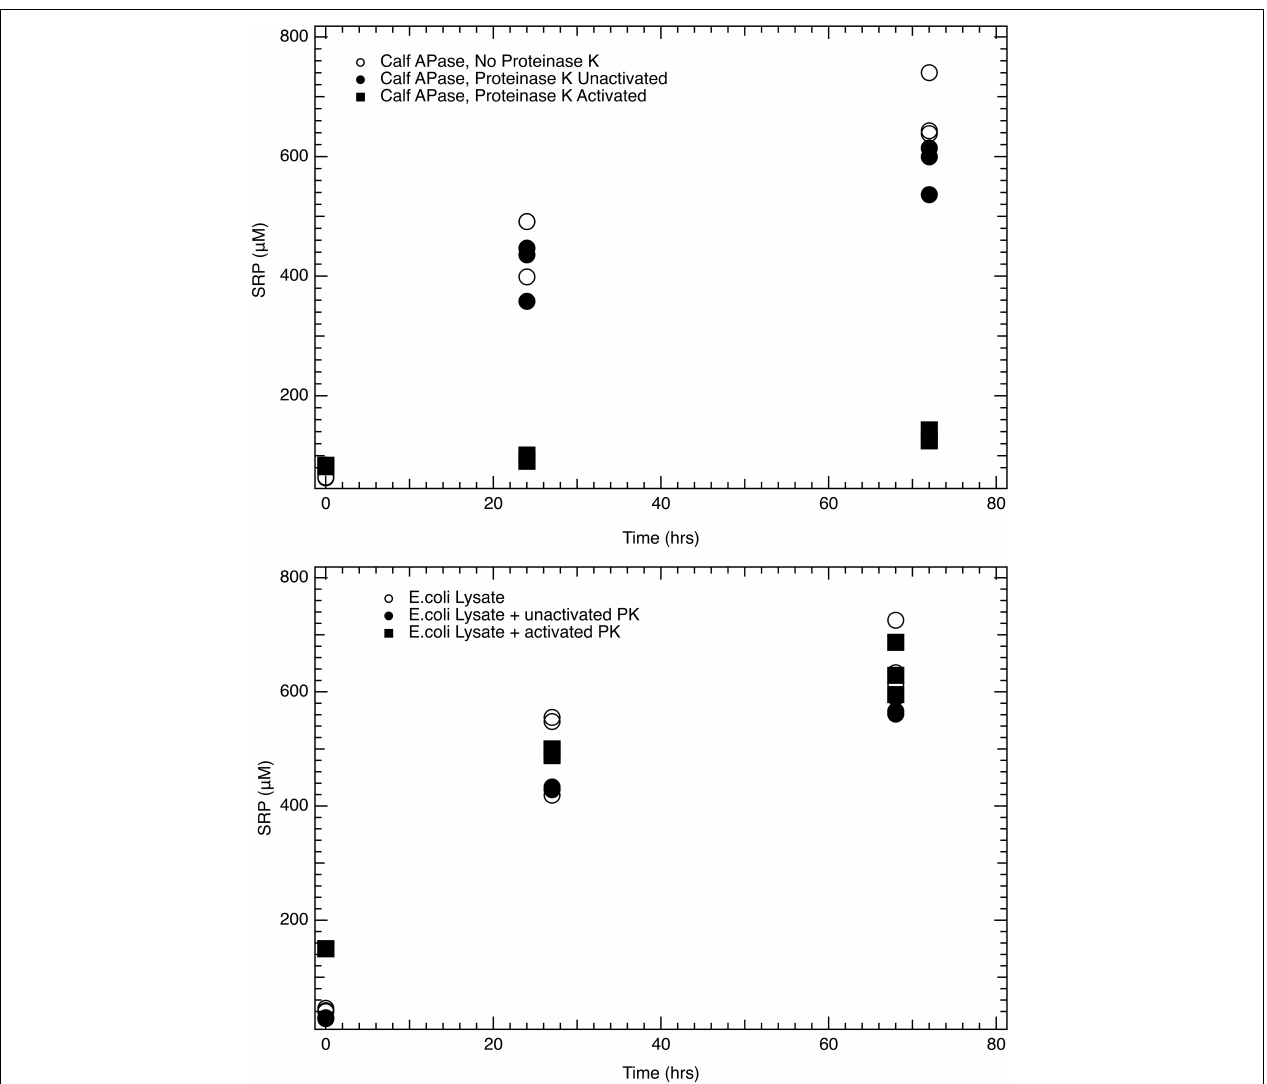
FIGURE 3 | Proteinase K treatment of purified enzyme and lysate: (Top) Change in soluble reactive phosphorus (SRP) concentration during incubation of a 1 mM glycerophosphate solution with calf purified APase under three conditions: (1) open circles represent APase enzyme with no proteinase K present; (2) filled circles represent APase with Proteinase K present, but no temperature activation of the enzyme; (3) filled squares represent incubations where APase is incubated with Proteinase K activated at 55 ◦ C. (Bottom) Change in SRP concentration during similar incubations in which calf APase is replaced by E. coli lysate in the incubations, again spiked to 1 mM glycerophosphate. Open circles represent incubations with only E. coli lysate, filled circles represent E. coli lysate incubated with unactivated proteinase K, and filled squares represent incubations with E. coli lysate and Proteinase K activated at 55 ◦ C. Purified APase showed a two order of magnitude reduction in activity when proteinase K was activated at 55 ◦ C. When incubated at room temperature, unactivated proteinase K had no observable effect on diminishing APase activity (top). Proteinase K had no effect on APase activity in fresh E. coli lysate even when it was heat activated at 55 ◦ C (bottom). Analytical errror bars are within the size of the symbol. Differences between unactivated and activated Proteinase K treatments are statistically significant P < 0.01. There is no statistically significant difference between the E. coli lysate